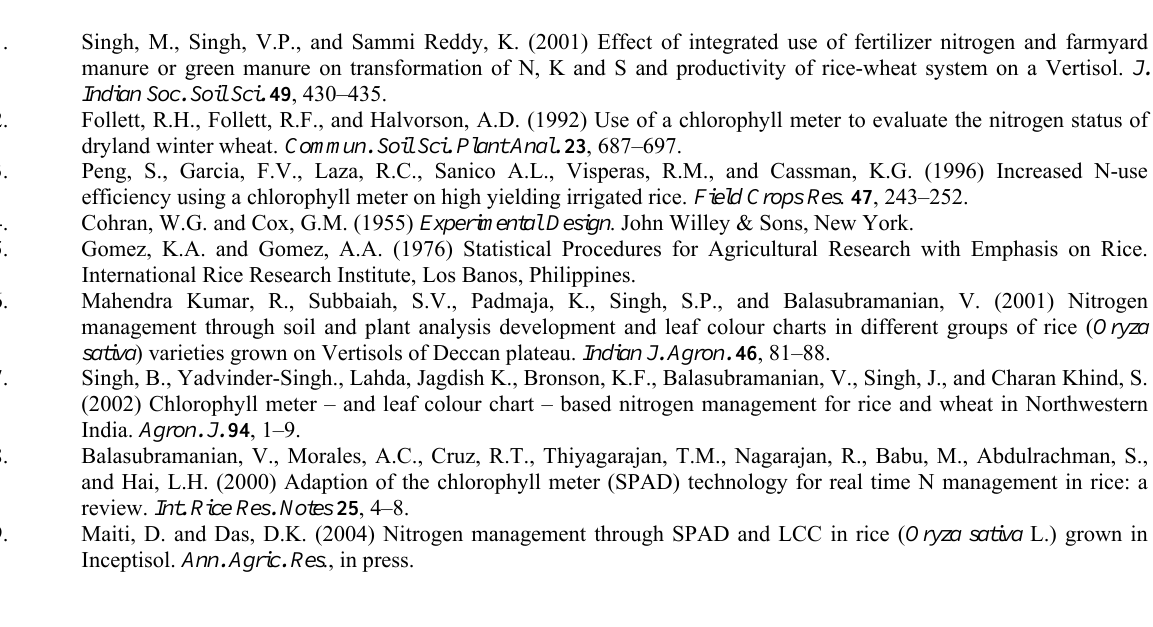
Levels of N: same as for Table